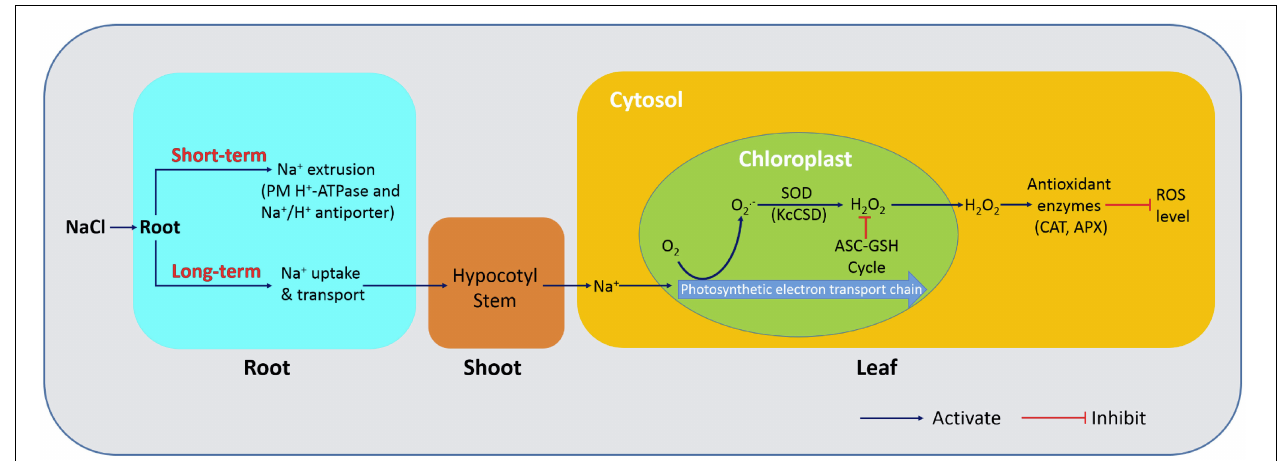
increased SOD activity in chloroplasts promotes the conversion of O − 2 to H 2 O 2 ; subsequently, chloroplasts scavenge and eliminate H 2 O 2 via the ascorbate-glutathione (ASC-GSH) cycle (Asada, 1999). Moreover, the activated antioxidant enzymes, such as catalase (CAT), and ascorbate peroxidase (APX), readily scavenge H 2 O 2 when the molecule diffuses across thylakoid membranes to the cytosol. As a result, the efficient scavenging of Na + -elicited ROS in chloroplasts avoids an occurrence of oxidative burst, and thus alleviates chloroplast injury from excessive ROS under the